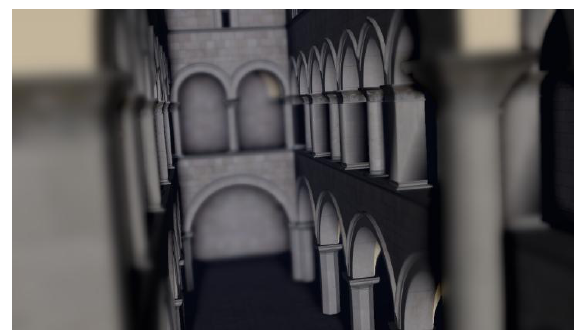
Figure 3. GrIP: Rendering of Sponza with depth darkening, depth of field and fog using the values from the GUI screenshot above